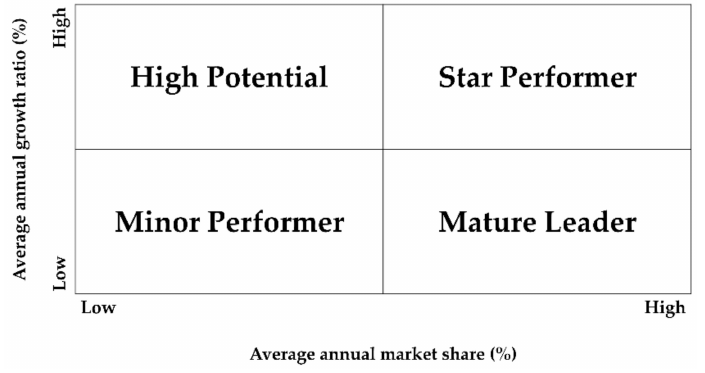
Figure 4. Growth-market share matrix applied to the port